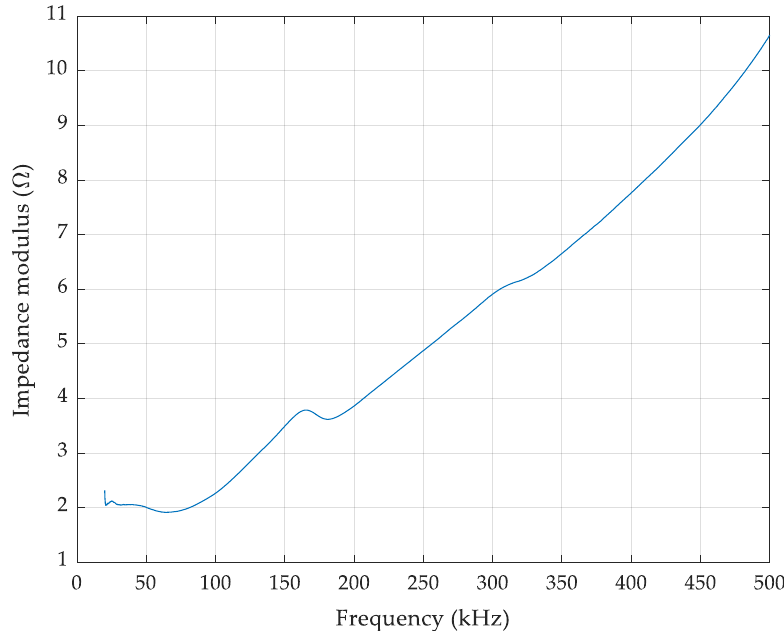
Figure 3. Measured impedance modulus of the Line Impedance Stabilization Network (LISN) model for the frequency band of interest. for the frequency band of